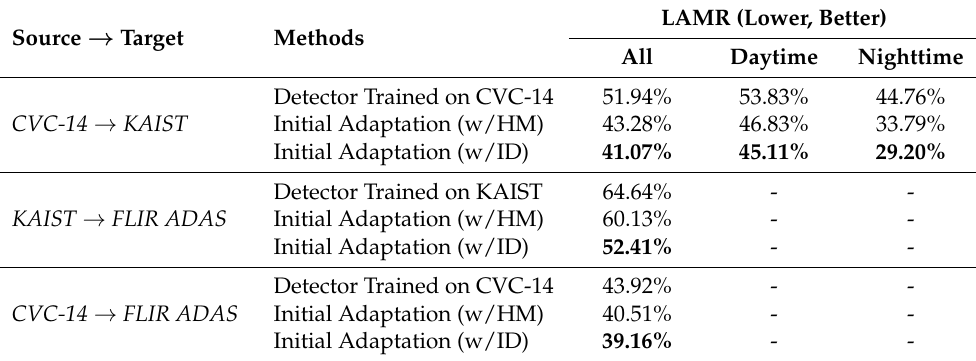
Table 3. Ablation study of intermediate domain (ID) in terms of Log-Average Miss Rate (LAMR). Results of detectors trained with original source images and histogram matched (HM) synthetic images are reported for comparisons. The best results are highlighted in